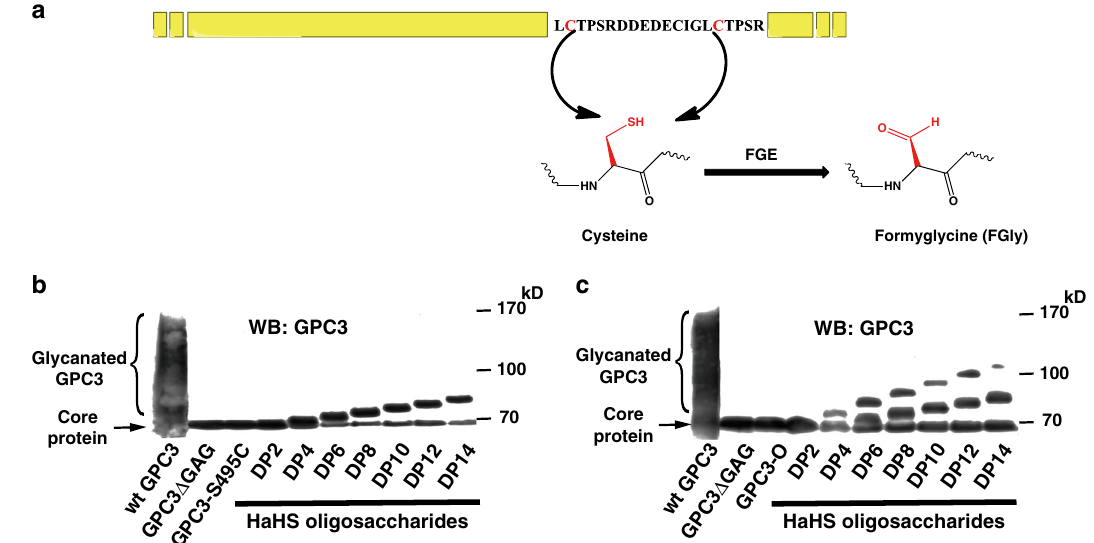
Fig. 1 Speci fi c oligosaccharides can be inserted into the GPC3 core protein. a Schematic diagram of the methodology used to introduce the aldehyde- bearing residue fGly into the GPC3 core proteins present in cell lysates of transfected 293T cells. b , c Various HaHS oligosaccharides of the indicated sizes were conjugated to GPC3-S495C with a single aldehyde-tag ( b ) and to GPC3-O with two aldehyde tags ( c ). The levels of modi fi ed GPC3 core proteins were assessed by WB analysis with a GPC3 antibody. wt GPC3, wild-type GPC3. All experiments were repeated three times with similar results. Source data are provided in a Source Data fi